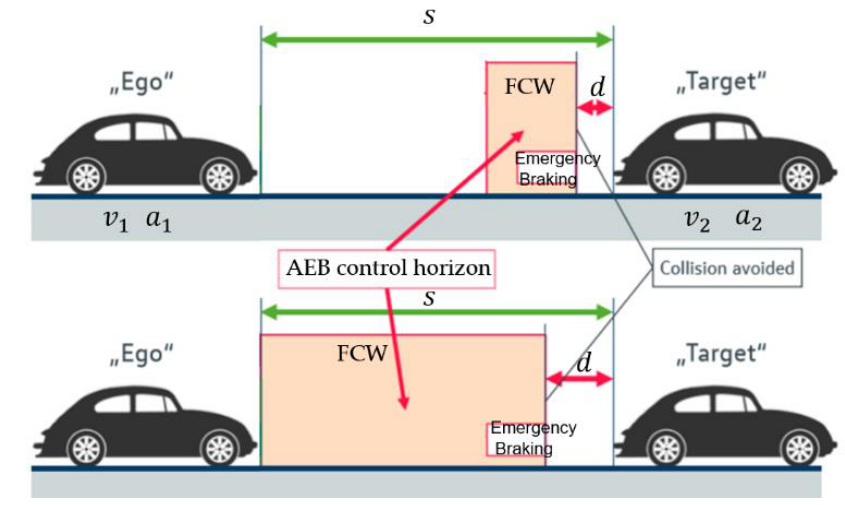
Figure 5. Schemes for AEBS control logic in CCRb.